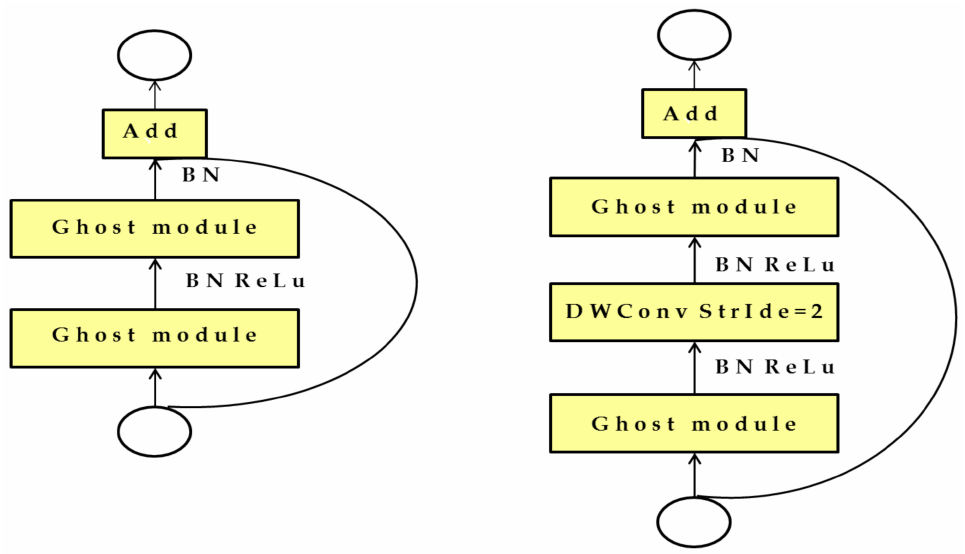
Figure 2. Structure diagram of ghost